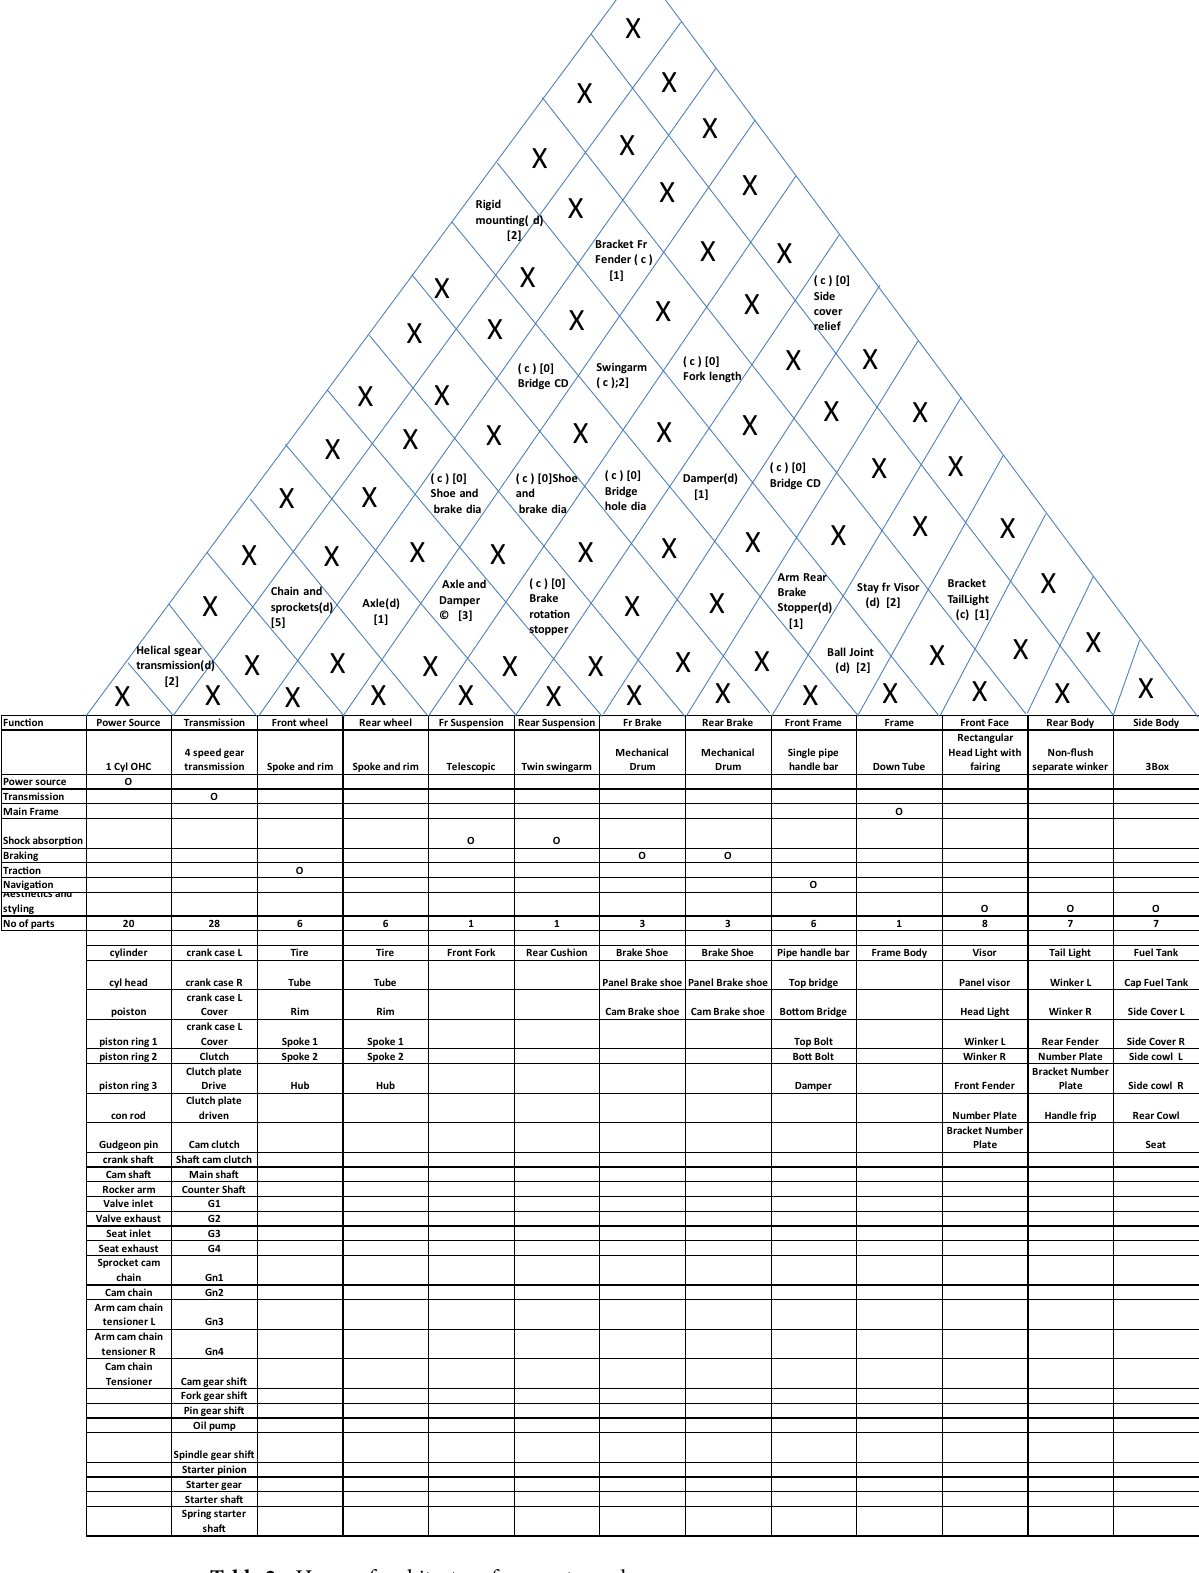
Table 2. House of architecture for a